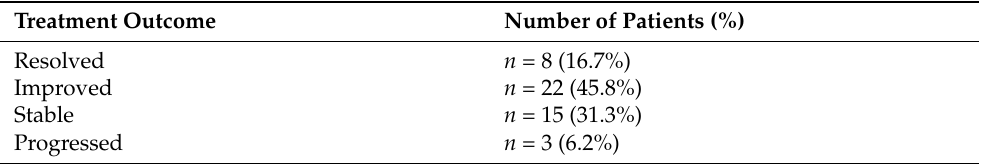
Table 6. Overall treatment